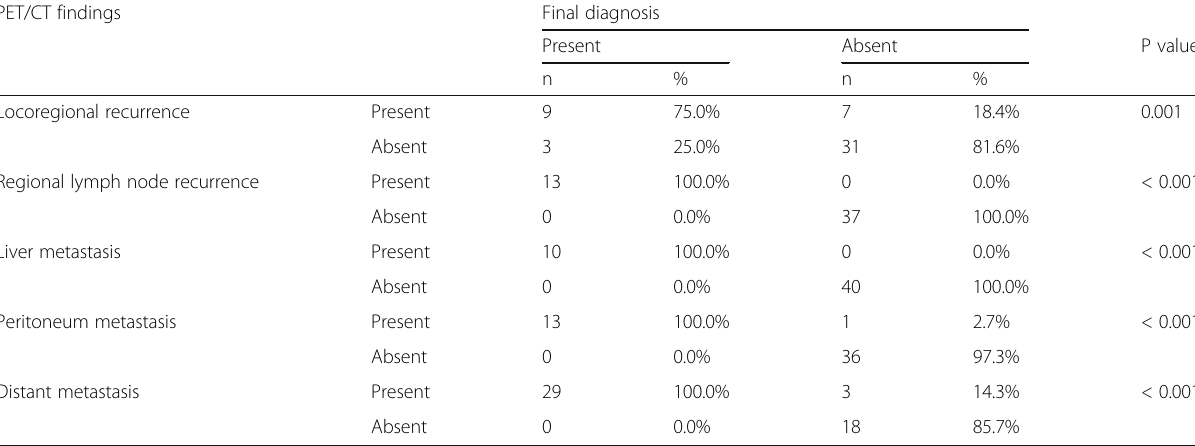
Table 2 Comparison between PET/CT findings and final diagnosis in all five groups PET/CT findings